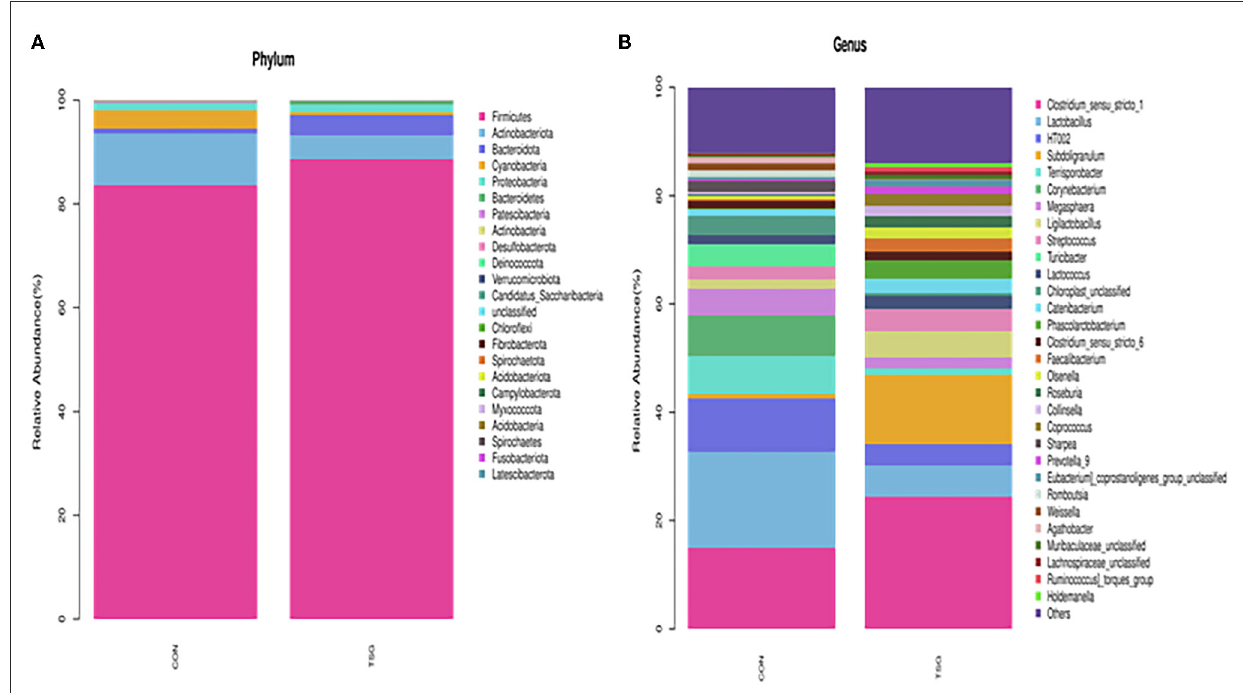
FIGURE4 16S rRNA: Microbial composition. (A) Bacteria detected at the phylum level. (B) Bacteria detected at the genus level.